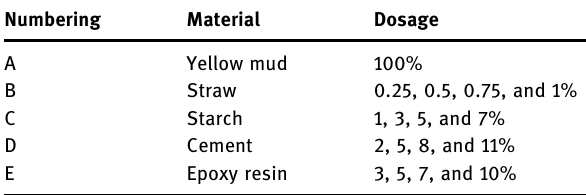
Figure 3: XRD pattern of yellow mud.